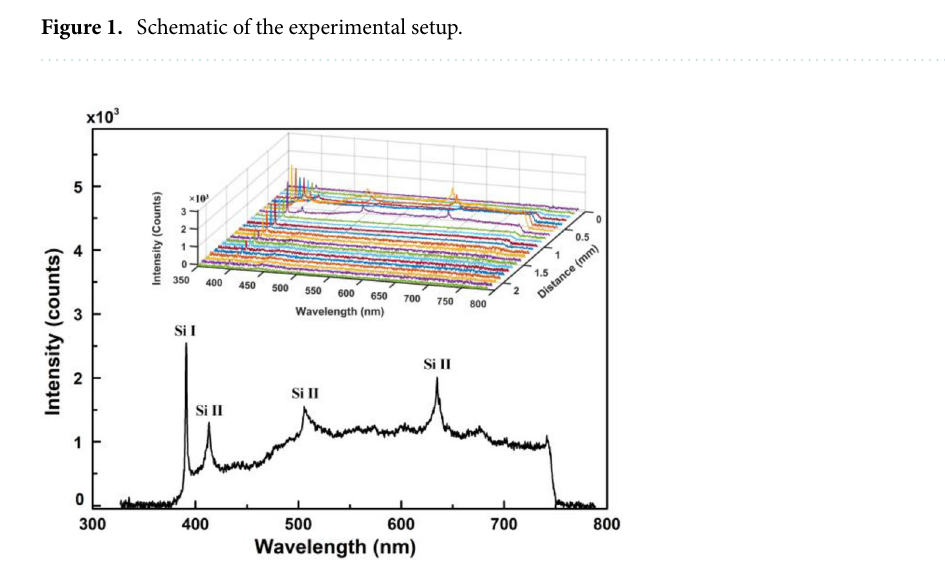
Figure 2. The spectrum of the plume at x = 0 and z = 0.6 mm. Inset: spectra at different distances along the